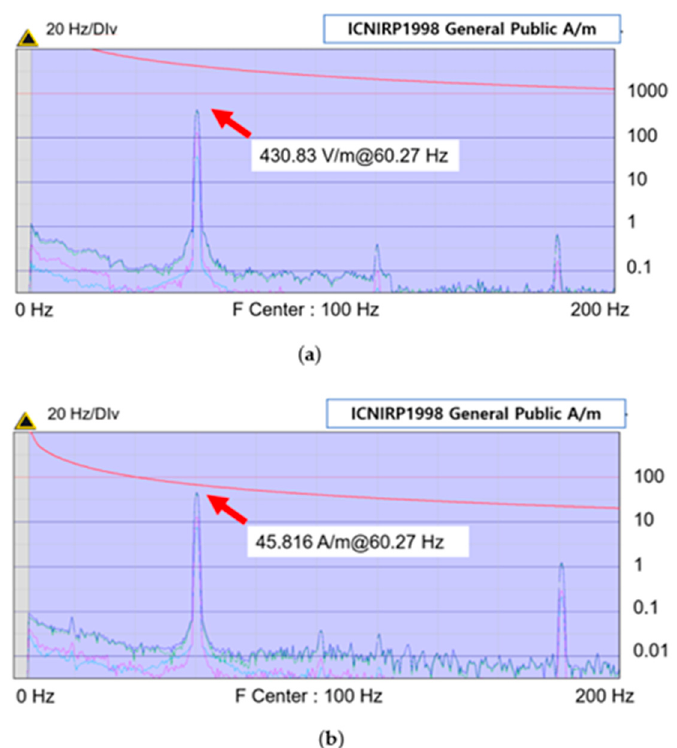
Figure 4. RMS mode electromagnetic field maximum: ( a ) electric field measurement and ICNIRP 1998 General Public reference level; ( b ) magnetic field measurement and ICNIRP 1998 General Public reference level.